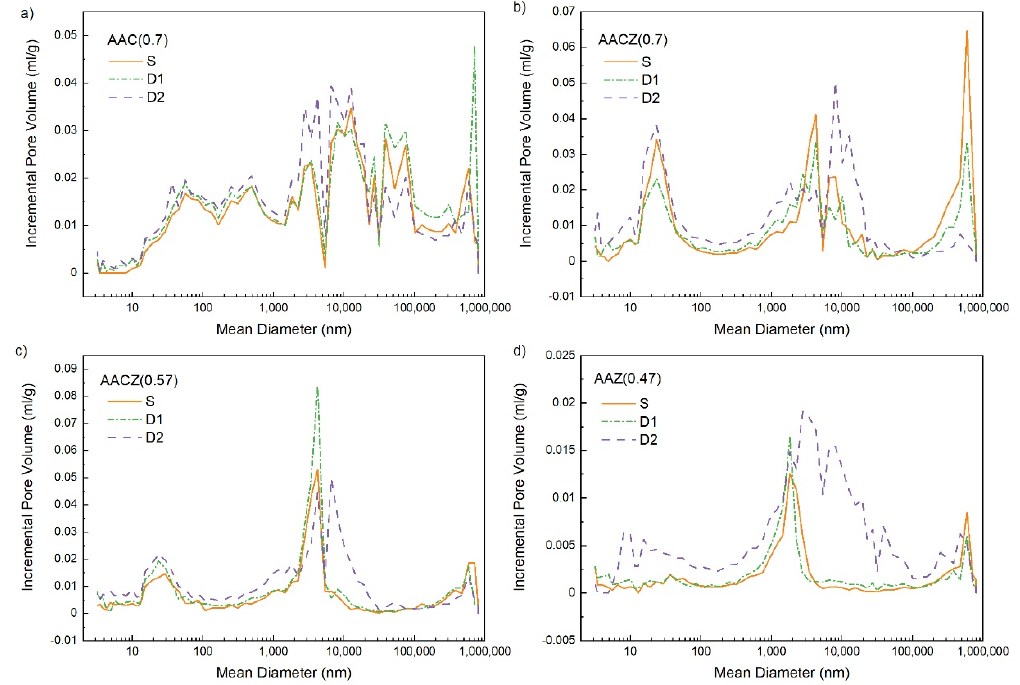
Figure 5. Pore size distribution of AAC (0.7) ( a ), AACZ (0.7) ( b ), AACZ (0.57) ( c ) and AAZ (0.47) ( d ) samples determined using Hg porosimetry.